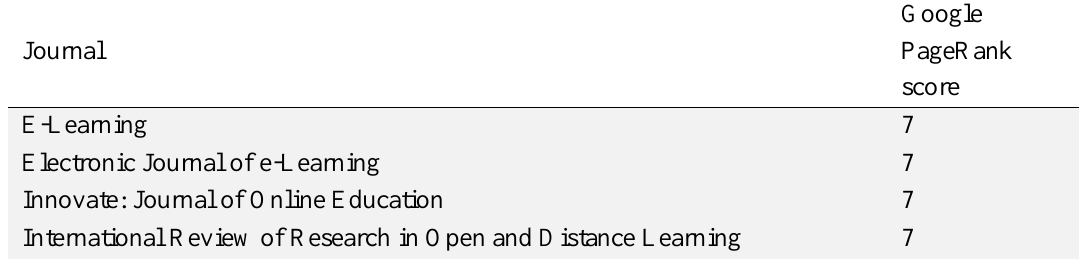
Alphabetical Ranking of Scholarly CML Journal Cohort Web Sites by Google PageRank Score (N =